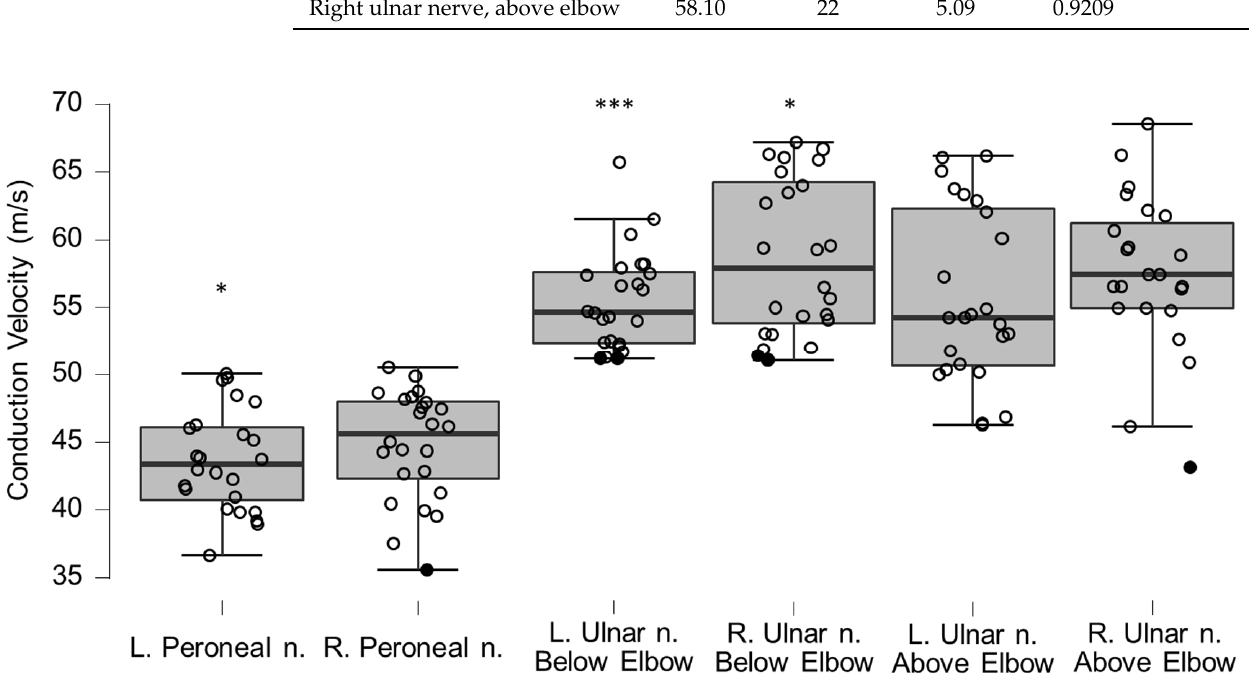
Figure 9. Box-plots for motor neurography conduction velocities. Lower and upper box boundaries represent the 25th and 75th percentiles, respectively. The line inside the box represents the median and the lower and upper whiskers represent the 10th and 90th percentiles. Filled circles represent values ≥ two standard deviations outside reference values. * and *** indicate statistically signifi- cantly lower median values compared to the reference material, with Bonferroni-corrected p -values corresponding to 0.05 and 0.001, respectively. Table 8. Sensory neurography amplitudes for left and right sural and ulnar nerves.